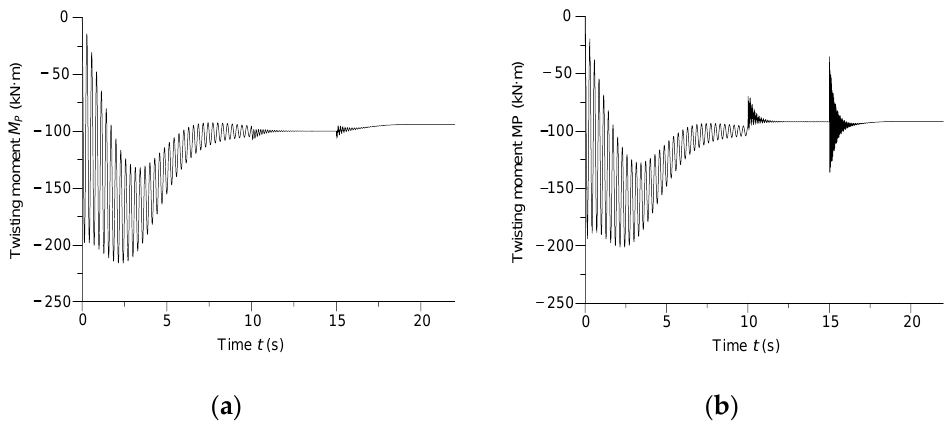
Figure 10. The instantaneous moment of torsion of the ( a ) second shaft and ( b ) fourth shaft of the ship’s motion transmission.